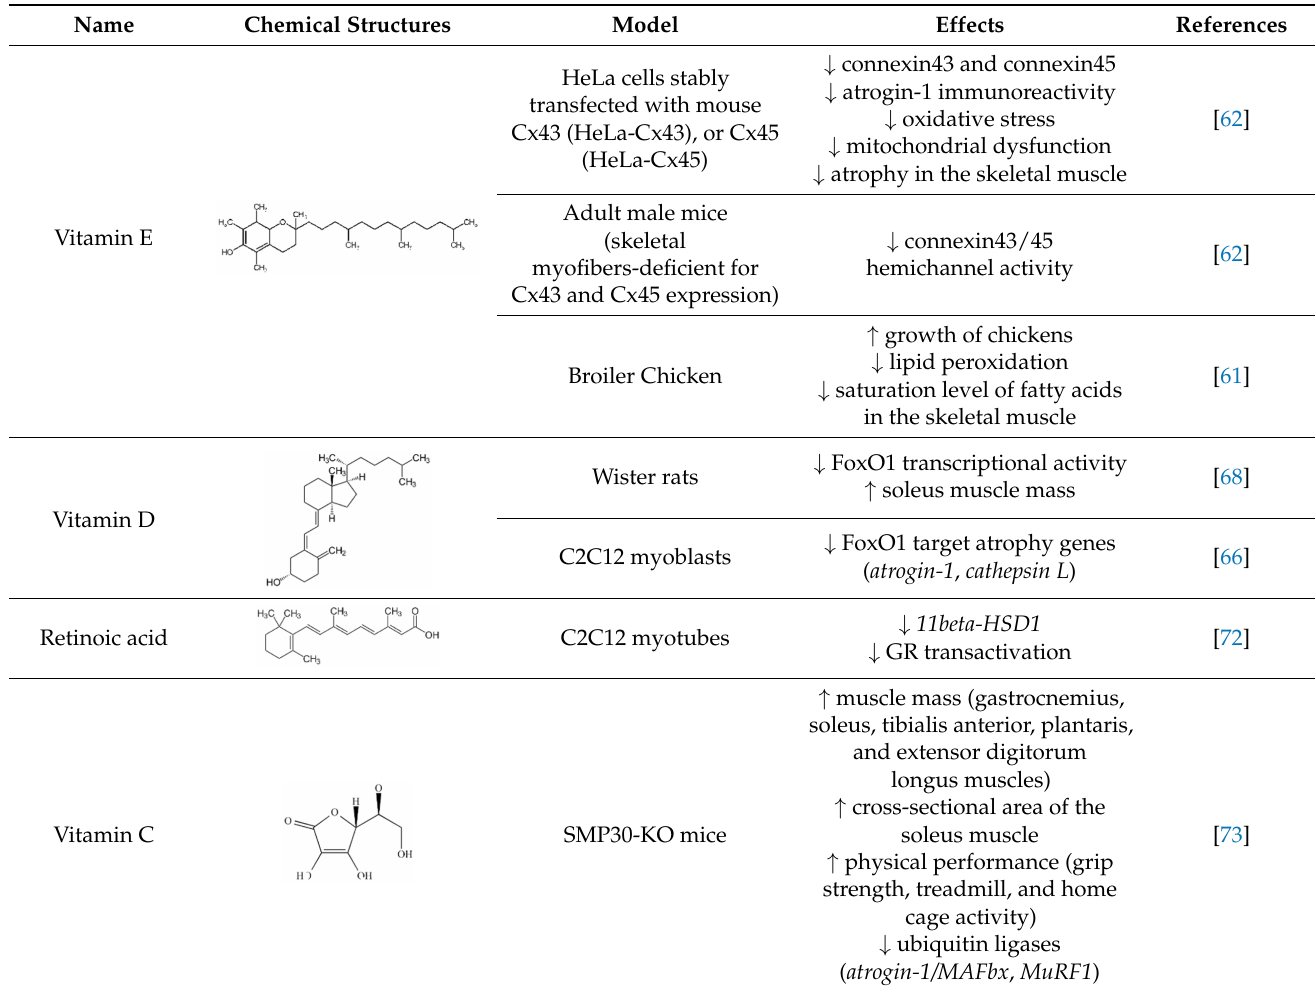
Table 3. The role of vitamins in glucocorticoid-induced muscle